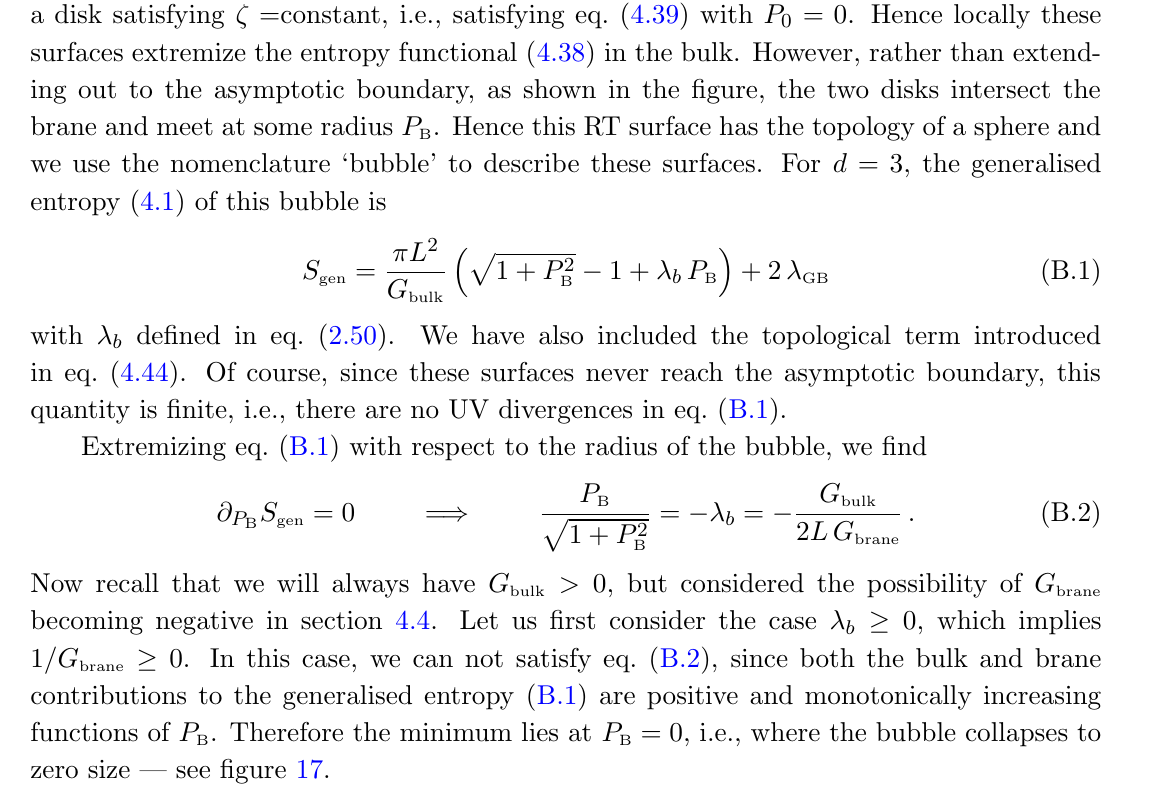
Figure 16 . An RT ‘bubble’ on the brane: even for the vacuum, when G and brane area terms can lead to a stable extremal surface, which is homologous to the entire time slice for the boundary CFT. The entanglement wedge then corresponds to the shaded red